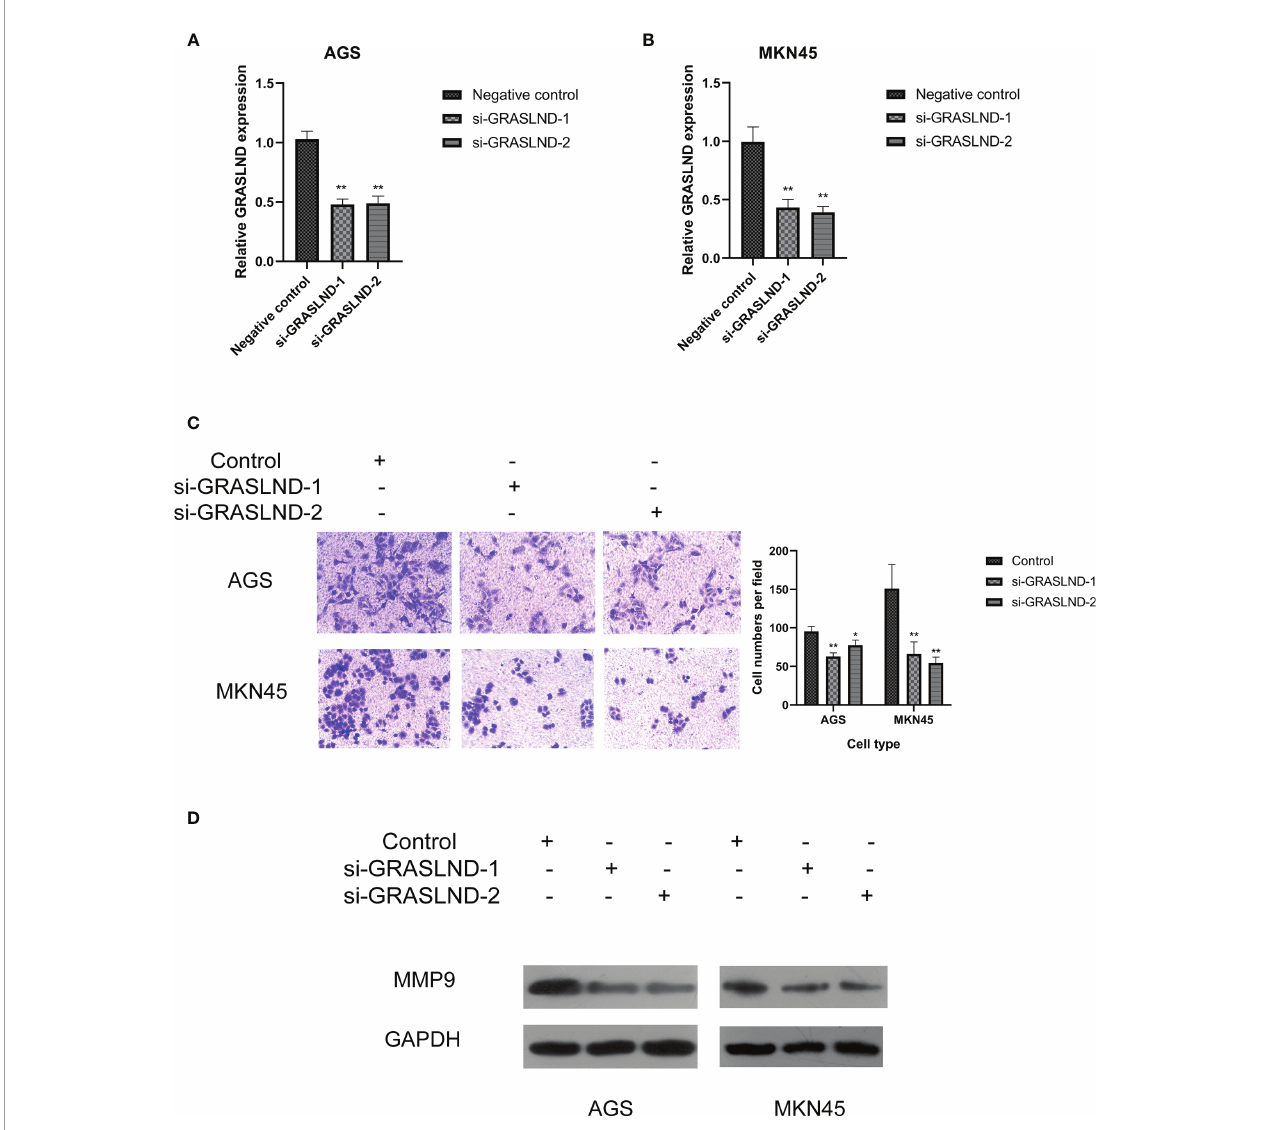
FIGURE 11 | Effects of lncRNA GRASLND on the regulation of extracellular matrix in GC cells. (A) AGS and MKN45 cell lines were transfected with si-GRASLND, and qRT-PCR was performed to con fi rm the knockdown ef fi ciency. (B) Knockdown of lncRNA GRASLND decreased the invasive ability of MKN45 cells. (C) Knockdown of lncRNA GRASLND decreased the invasive ability of AGS cells. (D) Knockdown of lncRNA GRASLND decreased the protein level of MMP9. * p < 0.05, ** p <